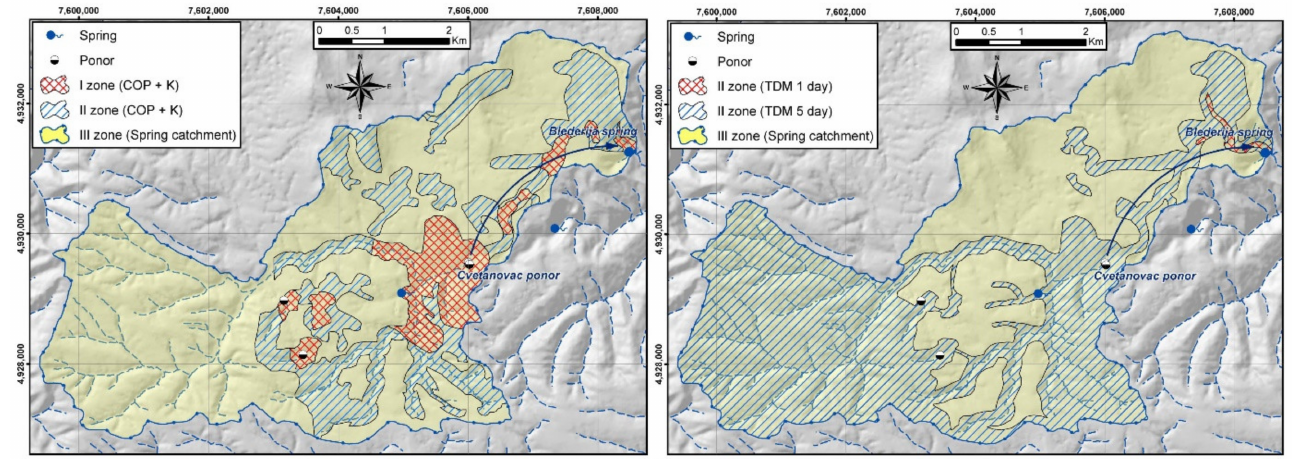
Figure 10. Sanitary zones based on COP + K method ( left ) and TDM method ( right